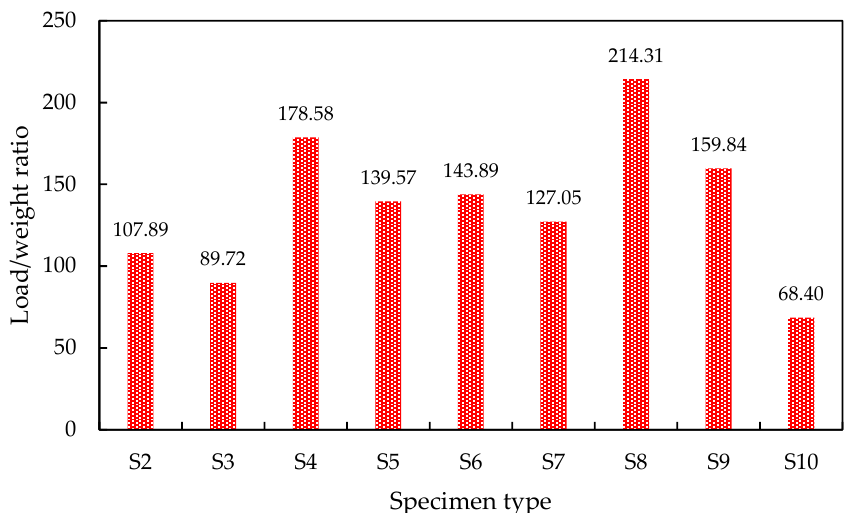
Figure 11. The axial stiffness of the ICF walls.